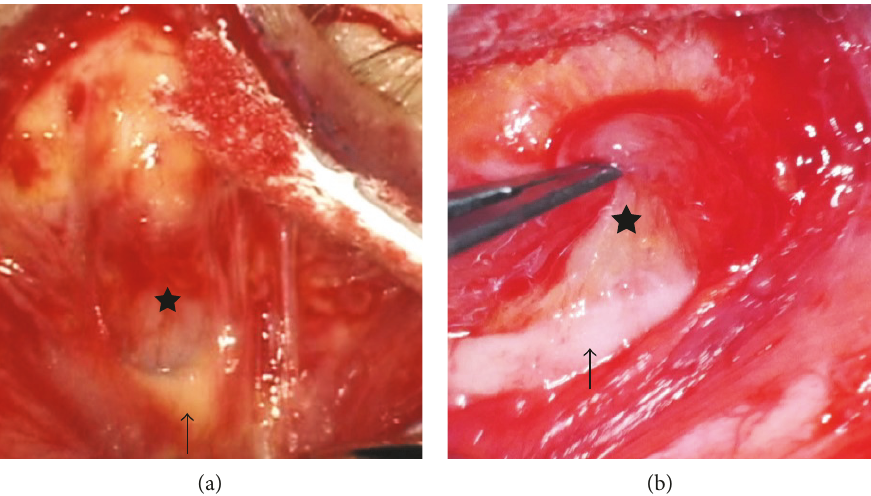
Figure 5: Levator resection in oculoplastic surgery. Muller ’ s muscle (star) and Whitnall ’ s ligament (arrow) can be seen in both images. The contrast of the image is improved in the 4K image (b) compared with that in the conventional video image